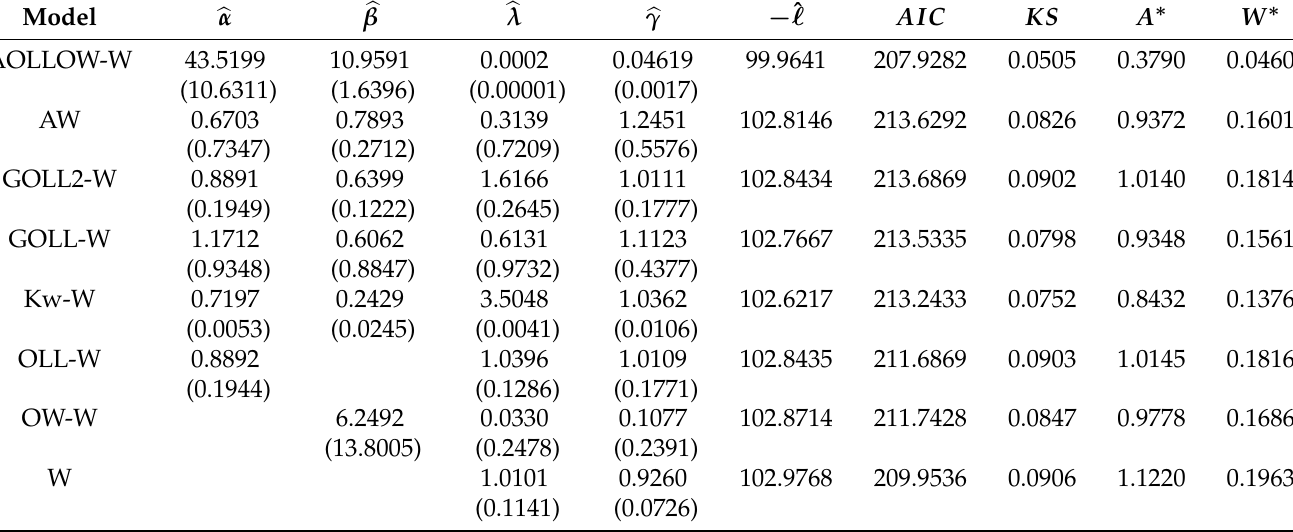
Table 2. The results of the first data set (standard errors of the estimates are in parentheses).